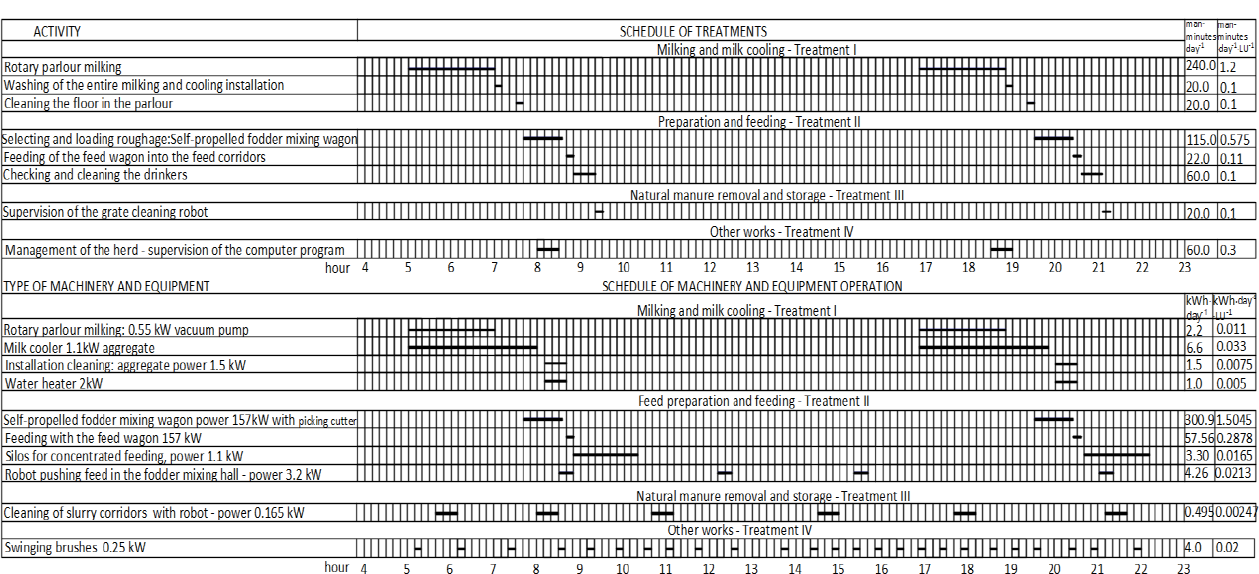
Figure 2. The schedule of a working day for service, machinery, and equipment (own study) in a module cattle barn.